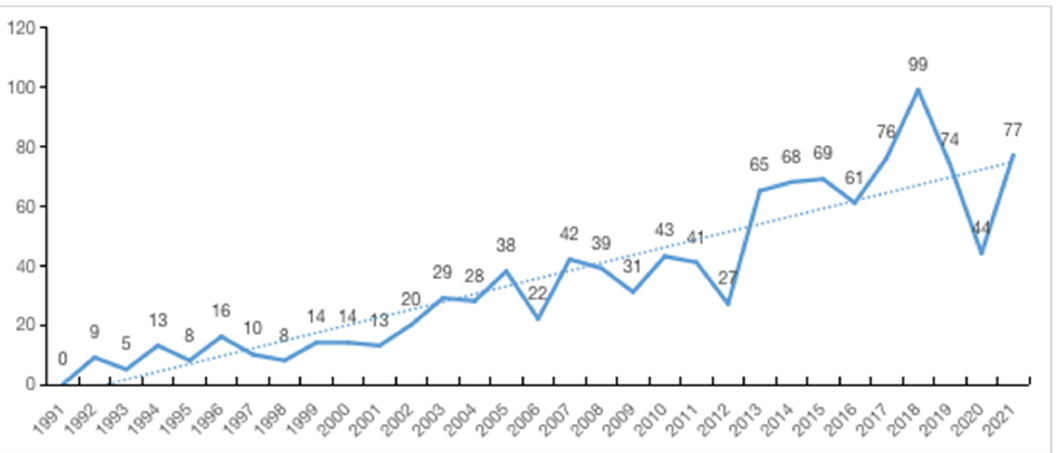
Figure 1. The number of Chinese studies with time.